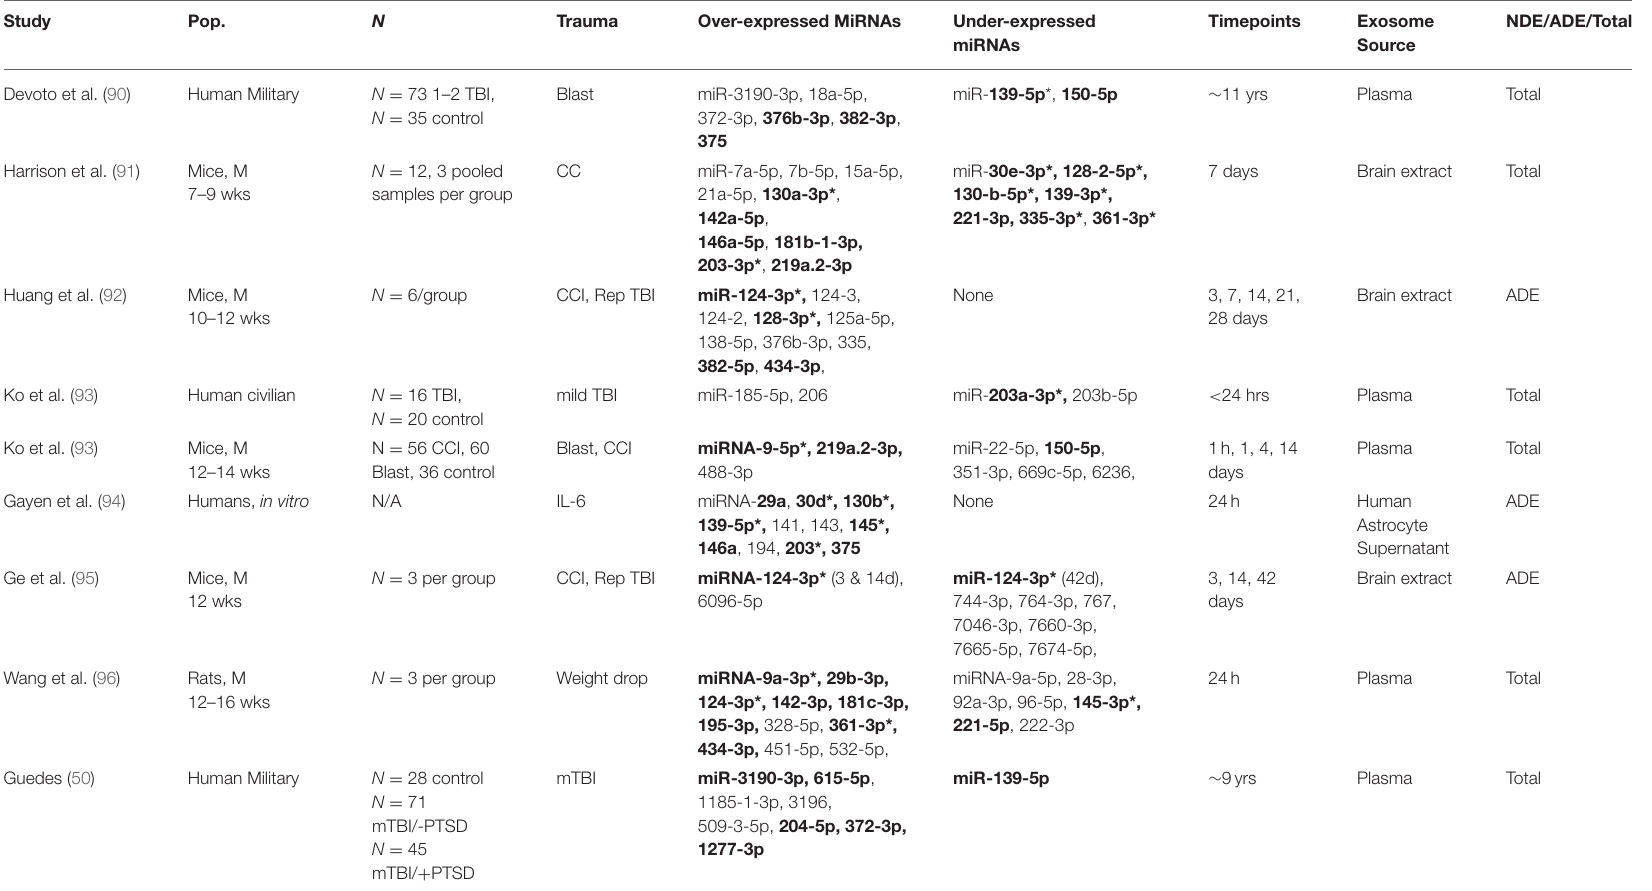
TABLE 2 | miRNAs of interest across